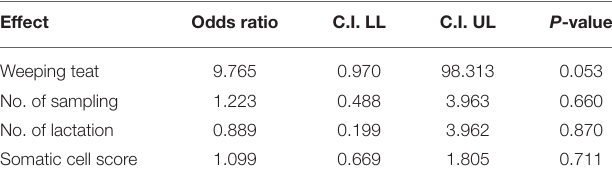
TABLE 3 | Results of the linear general mix model in herd A sampled in 2018 on fixed effects in Model